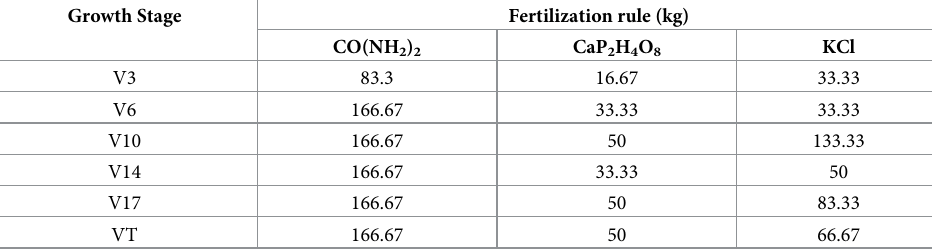
Table 1. Detailed information on irrigation scheduling at different silage corn growth stages used per ha. Growth